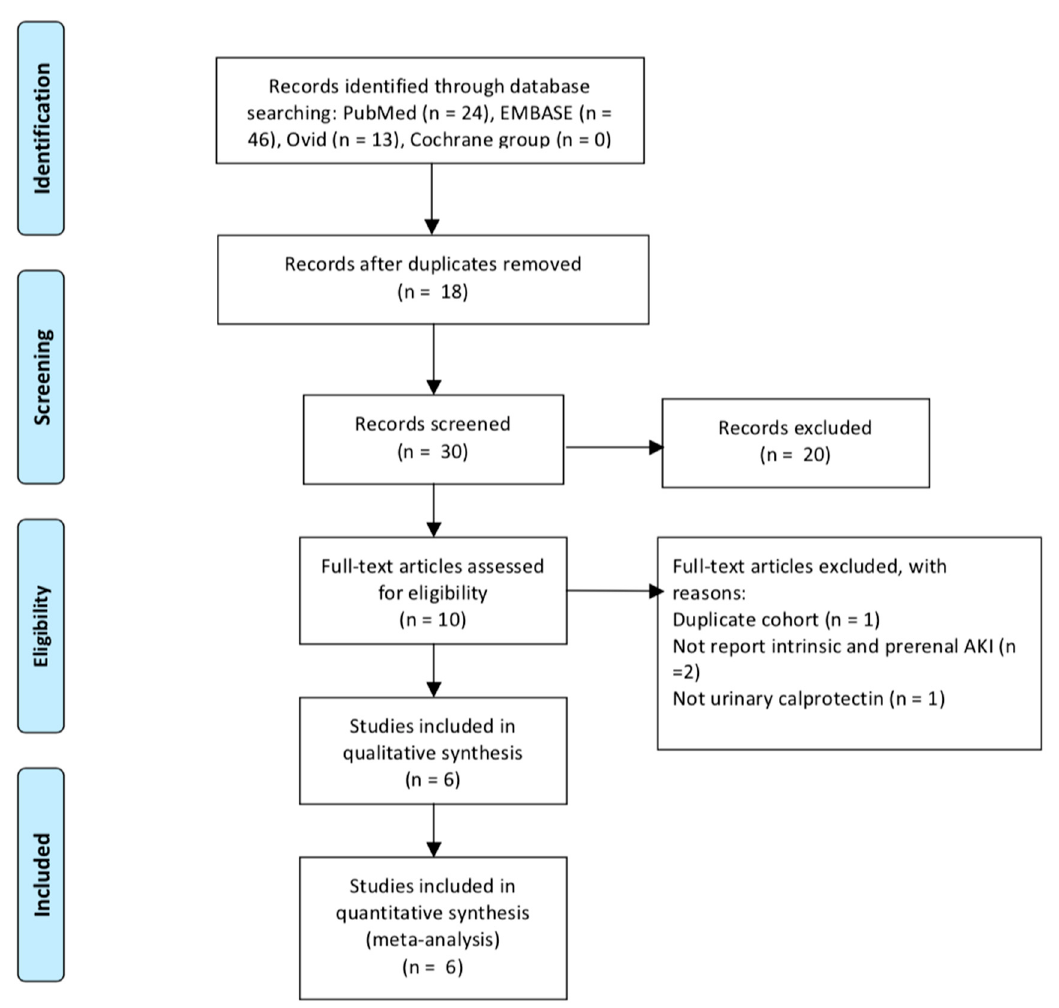
Figure 1. Preferred Reporting Items for Systematic Reviews and Meta-Analyses (PRISMA) flowchart.